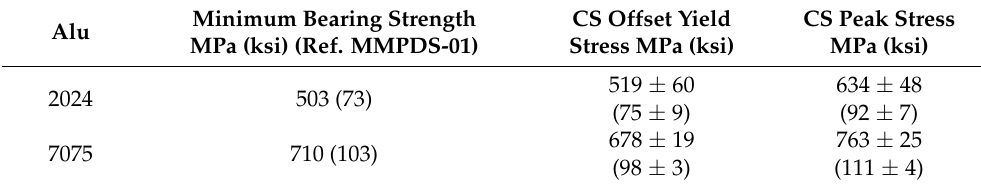
Figure 13. Schematic illustrations showing the various failure modes from the bearing test. Table 2. Summary of bearing strength test